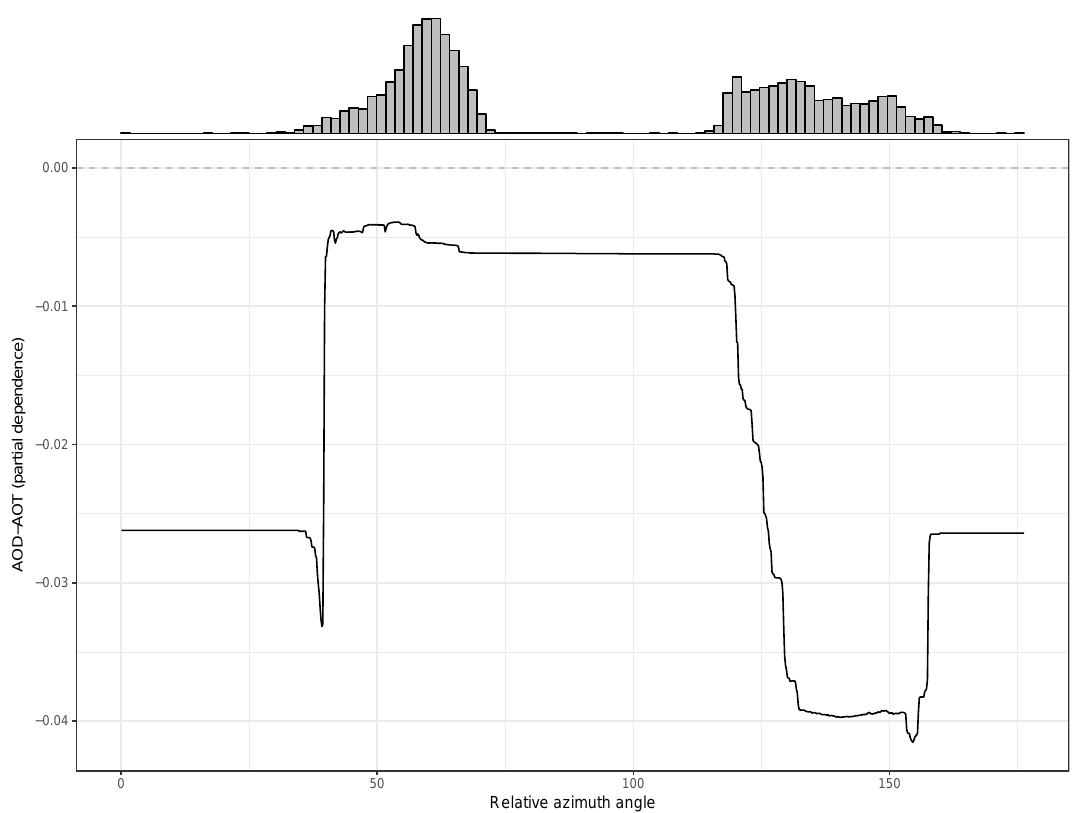
Figure 5. Partial dependence plot of measurement error as a function of relative azimuth for the Aqua training set ( n = 7280) from the GBM approach. The marginal histogram shows the bimodal distribution of relative azimuth for these Aqua retrievals, with larger errors (further from zero) seen for the second mode with angle >120 ◦ in backscattering